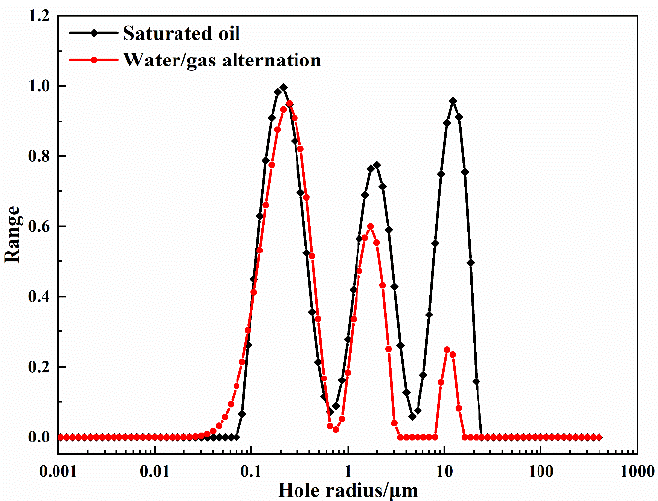
Figure 3. Distribution of pore throat radius before and after water/gas alternation in core No.1.